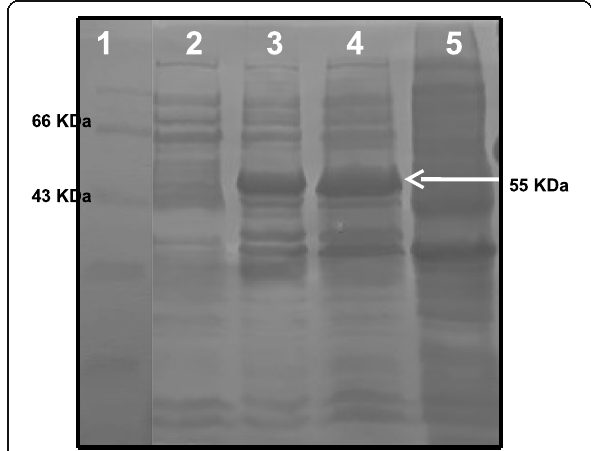
Fig. 4 Analysis of expressed recombinant cellulase on 10% SDS- PAGE. Lane 1, protein marker (GeNei); lane 2, supernatant of cell lysate; lane 3, pellet of cell lysate (20 μ l); lane 4, pellet of cell lysate (40 μ l) with arrow showing expressed cellulase protein; lane 5, BL21 cells carrying pET21a plasmid without gene